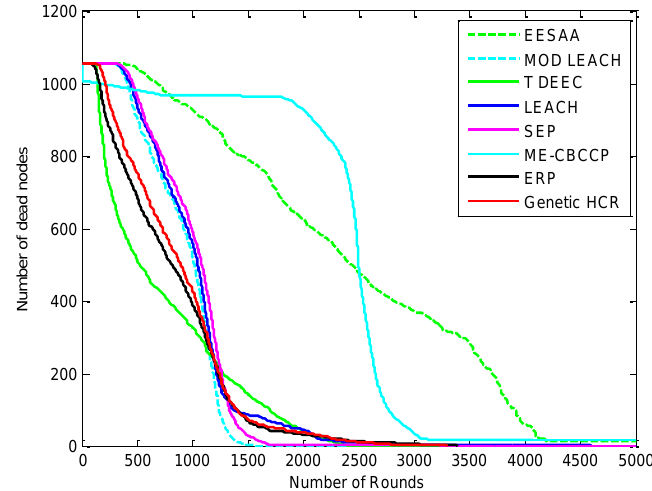
Figure 4. Network lifetime comparison (1000 nodes, with the help of dead nodes in 200 m 2 ).